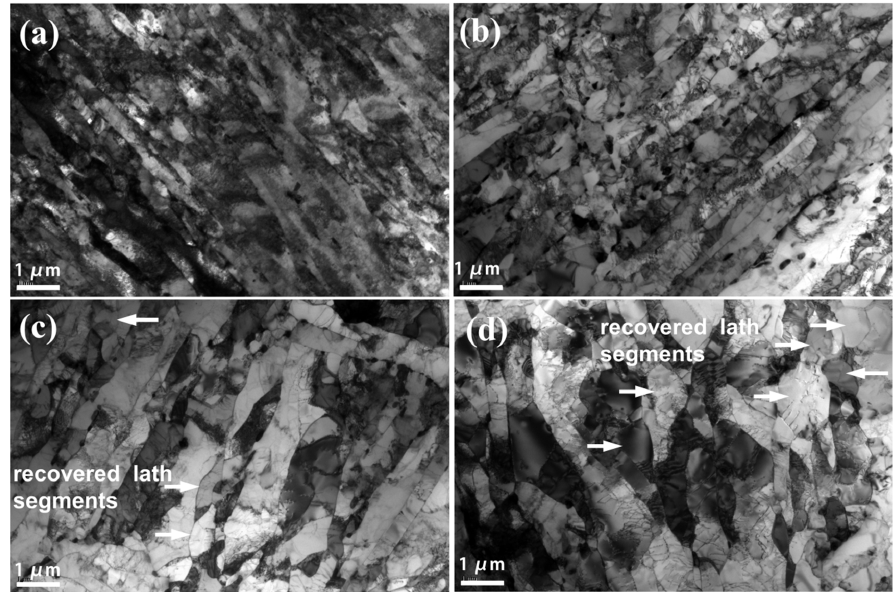
Figure 4. TEM images showing the recovery of martensitic lath structure in the present Gr.91 steels with different durations at 675 °C, including ( a ) 0 h, ( b ) 1000 h, ( c ) 4000 h, and ( d ) 16,000 h. The arrows in ( c , d ) indicate some recovered lath segments.